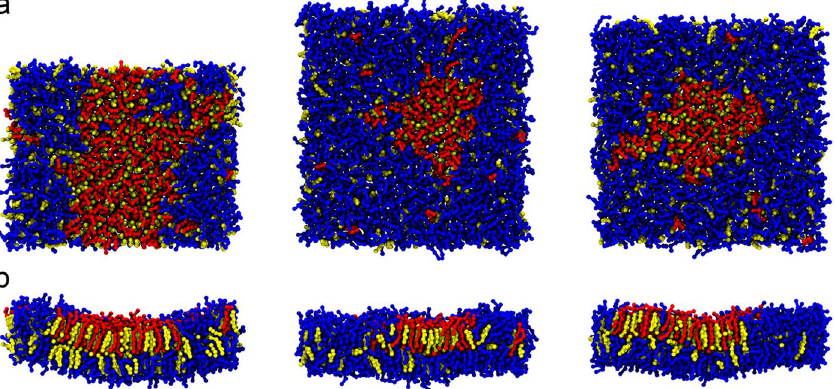
Figure 1. Membrane models. The ( a ) top and ( b ) side views of the VI, IN and HO membrane models are shown from left to right. DPPC, DLiPC and CHOL are shown as CPK models with red, blue and yellow colors,